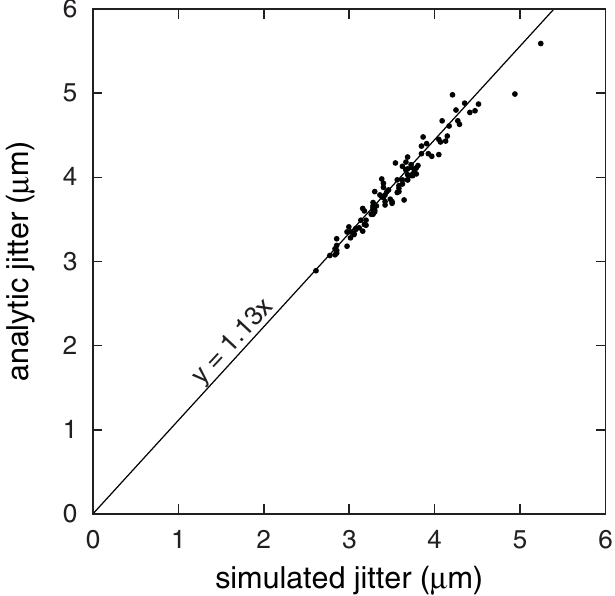
FIG. 6. Correlation between extraction jitter calculated ana- lytically and found from simulation, for 100 seeds of random injection